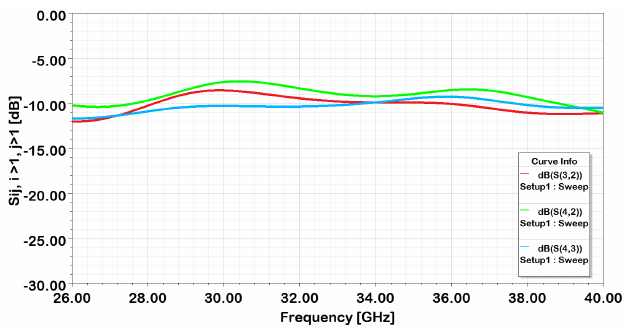
FIGURE 16. Isolation Losses of the system with a triple P-QWT.